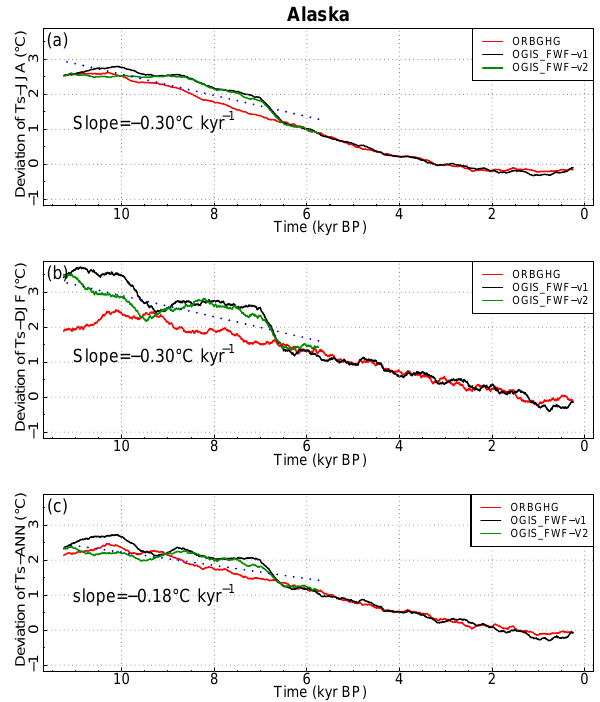
Figure 7. Same as Fig. 4 but for Alaska (170–120 ◦ W, 58–74 ◦